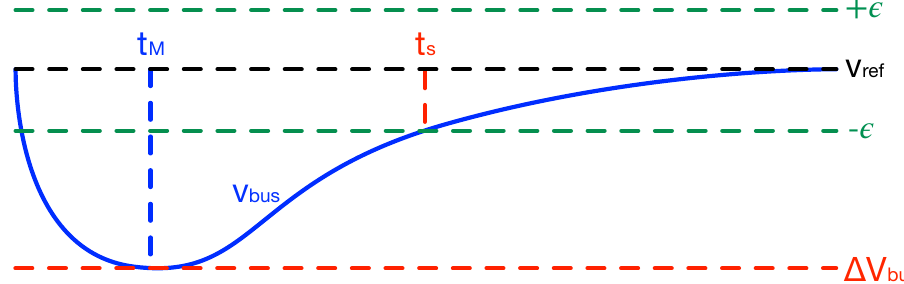
Figure 3. Design criteria of the bus voltage behavior ( ∆ V bus and t s